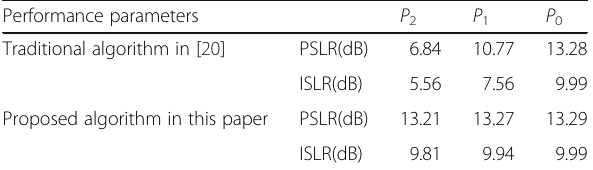
Table 4 Performance parameters in azimuth for case